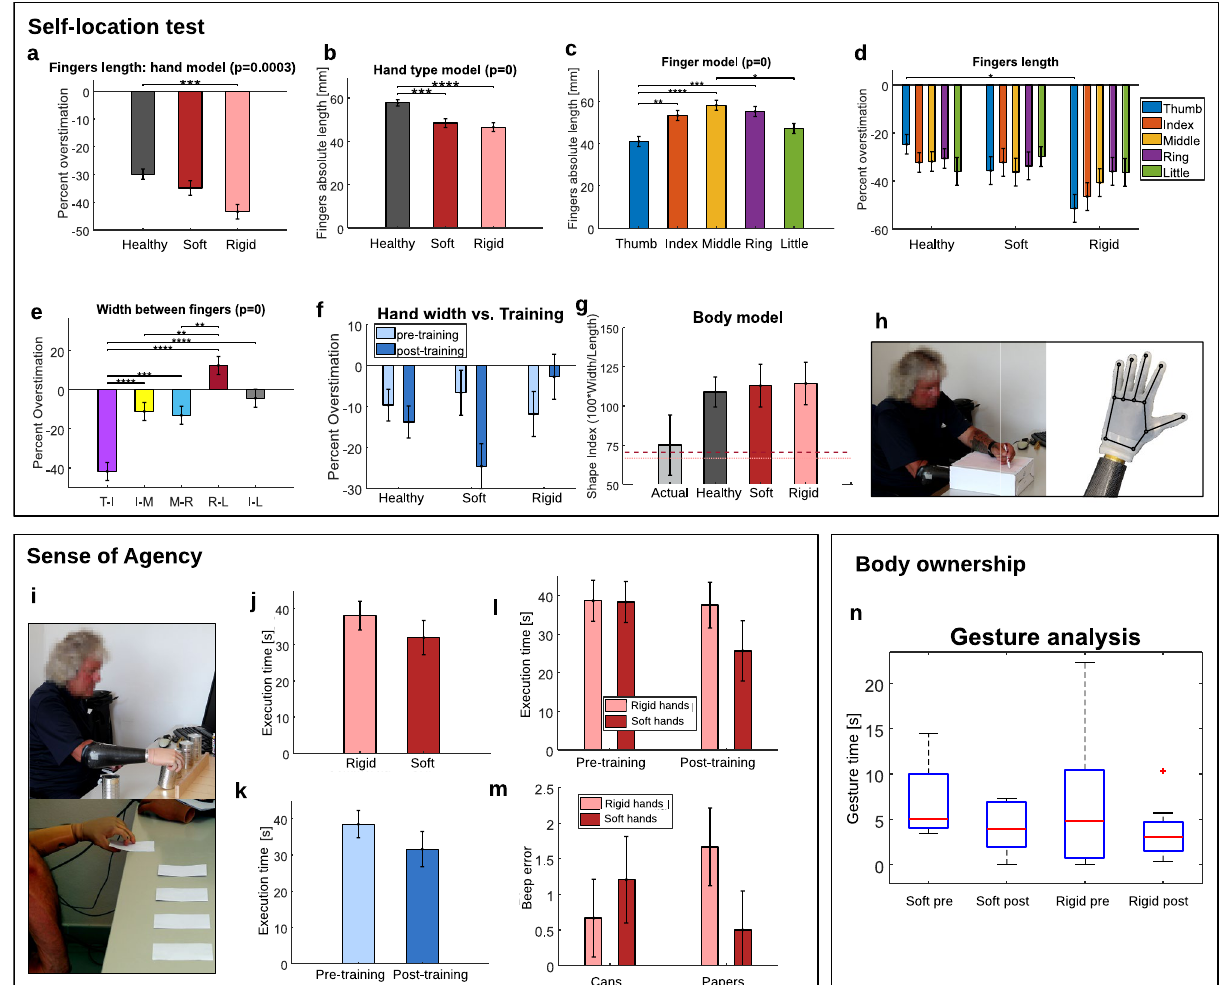
Figure 4. Embodiment assessment. Significant p values obtained from n-Way ANOVA test for self-location and sense of agency tests are included in figures title. After a post-hoc Tukey test, significance is expressed with asterisks among bars, when occurs. Significant p values < 0.01 are expressed with **, p < 0.001 with *** and p < 0.0001 with ****. ( a – d ) Present the analysis of the fingers length with the corresponding estimated means and standard errors of each group. Data are presented as percent of overestimation and absolute values. ( e – f ) Shows the analysis of the width estimation and its relation with training for each system, respectively. ( g ) Presents the distortion on the aspect ratio among hands, where “actual” refers to the anthropomorphic shape index of the subjects. The dashed and dotted lines refer to the real aspect ratio of the soft hand (SHP) and the rigid hand (i-limb), respectively. ( h ) Shows images of the experimental setup and the landmarks asked to mark. ( i – m ) Presents the results of the sense of agency test. All cases where the action was successfully performed— moving 5 cans or turning 5 card in less than 1 min were considered in the analysis of execution time. All cases where the subjects gave a valid response about the counted beeps were considered in the analysis of the beeps error. ( n ) Presents the body ownership test for s 5 , with information about the gesture